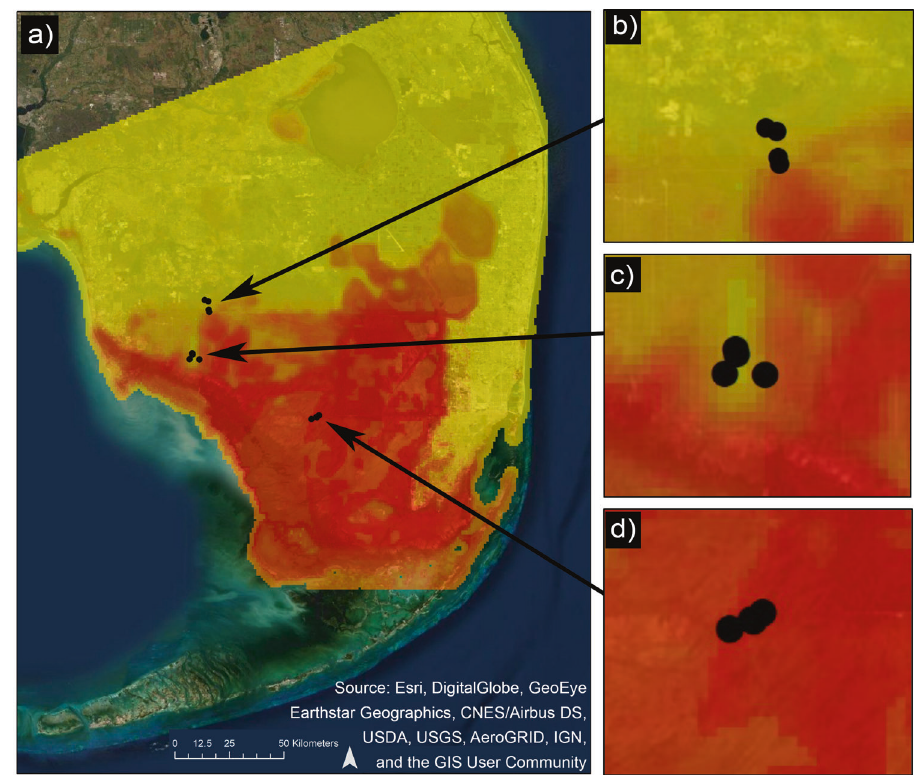
Fig. 1 Map of southern Florida with modeled relative presence of Burmese python and study sites. Burmese python observations were modeled using 1165 georeferenced python locations (2014 to 2017) from the Early Detection and Distribution Mapping System data base (https://www.eddmaps.org/). Shades of red indicated a higher estimated relative python presence. Relative python presence values generated by species distribution modeling using an ensemble modeling approach that combined model outputs from multiple SDM algorithms, executed in the “ biomod2 ” package in R. Black circles indicate mammal and mosquito sampling locations in southern Florida ( a ) at Florida Panther National Wildlife Refuge ( b ), Fakahatchee Strand Preserve State Park ( c ), and Big Cypress National Preserve ( d